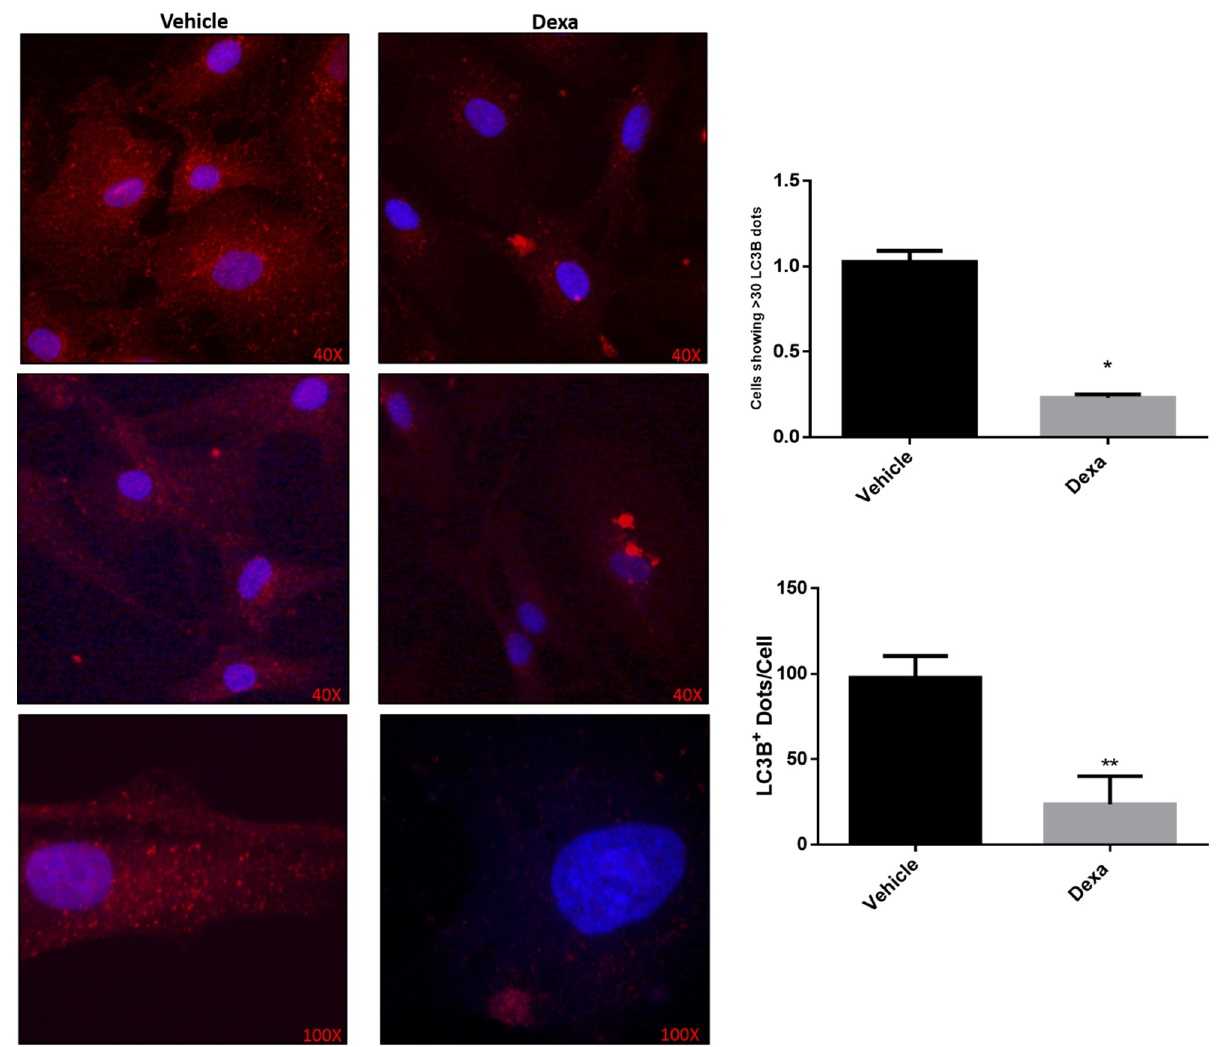
Figure 4. Decreased autophagosomes count in Dexa-treated TMCs. (A) Immunofluorescence microscopy analysis of LC3B + autophagosomes (e.g., red spheres) in vehicle and Dexa-6d* cells. Nuclei were stained by Hoechst. Images were acquired at 40X and 100X magnification. Autophagosome count was analyzed by means of either percentage of cells showing at least 10 LC3B + dots and average number of dots per cell. * p < 0.0001; ** p < 0.004. A representative experiment of two independent observations is reported ( n = 10); unpaired Students’ τ test.